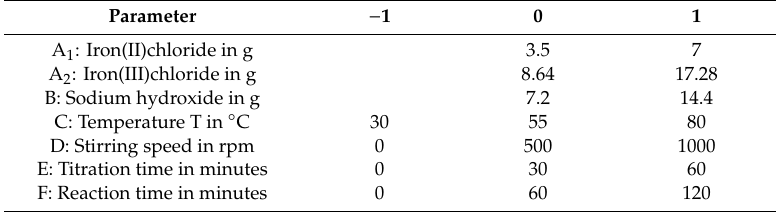
Table 1. Parameter range for design of experiments. For the substrates, the parameter range is between 0 und